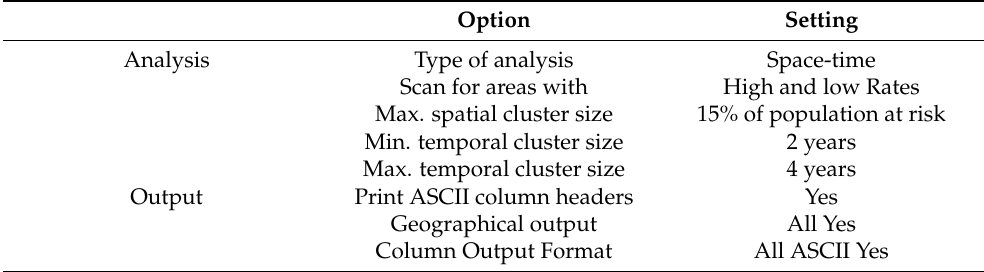
Table 2. SatScan settings used for the space-time analysis, different from default